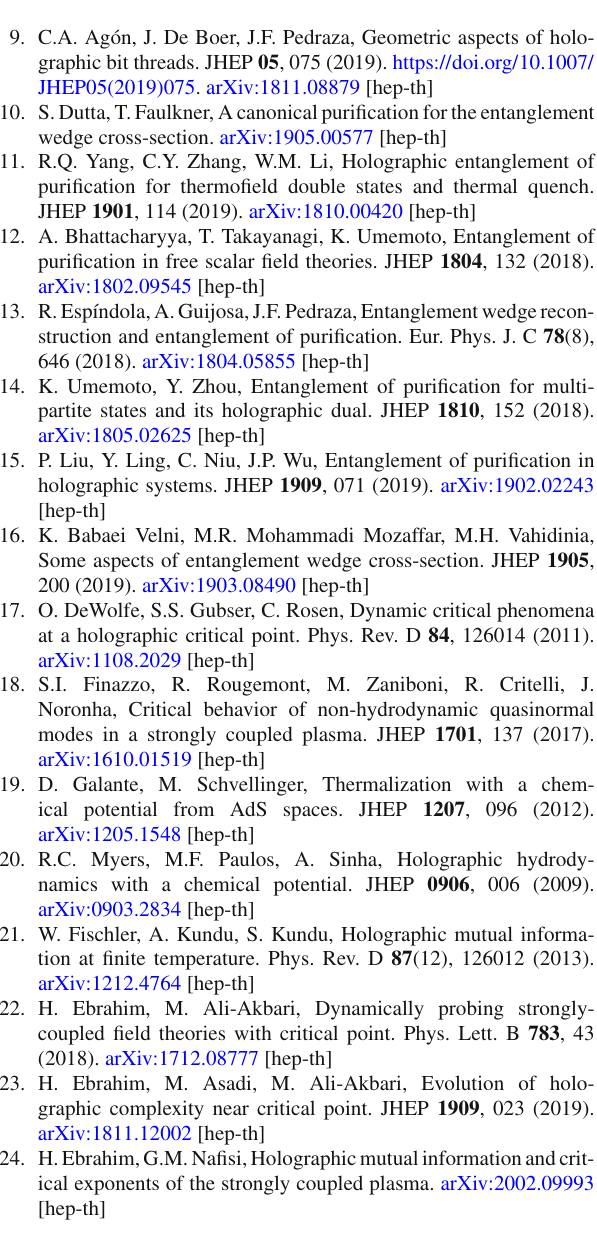
for l (cid:3) = 0 . 1 and different values of l . T is fixed and equal to 0 . T